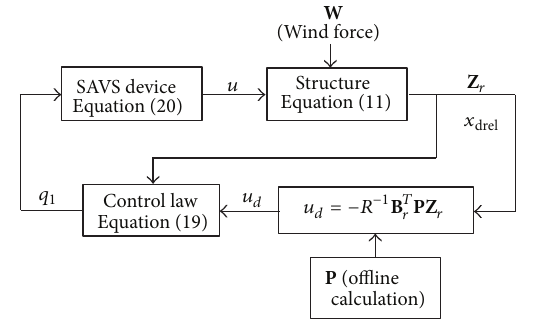
Figure 5: Block diagram for